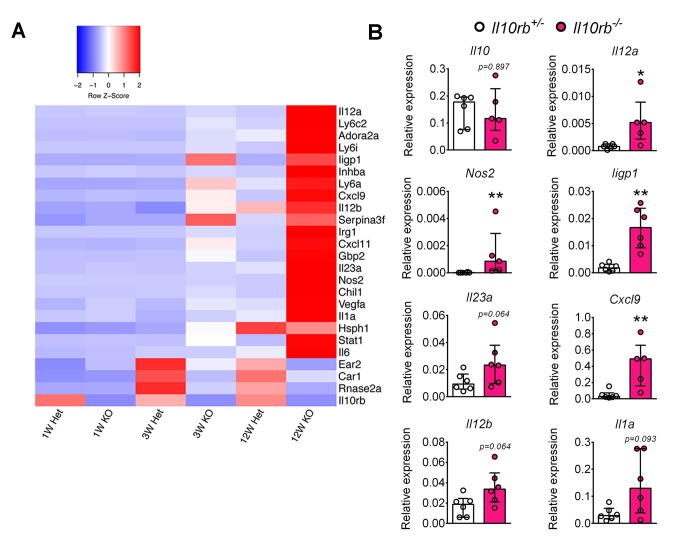
Lamina propria macrophages of infant Il10rb-/- mice exhibit proinflammatory transcriptional profile.Colonic LP MΦs (P3/P4; gated on CD45+CD11b+CD11cint CD103-CD64+Ly6C-MHCII+ cells) were sorted (minimum 10,000 cells), RNA was prepared, and RNA-seq was performed. (A) Heatmap showing relative expression intensity of >3 fold differentially expressed genes in the LP MΦs between Il10rb-/- (KO) and Il10rb+/- (Het) mice. Genes were identified based on the differential expression in LP MΦs between 3 week old Il10rb-/- and control mice. Each sorting time-point represents one mouse at 3 and 12 weeks, whereas pooled colons from 4 to 5 mice for 1 week data points were used. (B) Validation of RNA-seq data by qRT-PCR for selected genes and Il10 from LP P3/P4 MΦs sorted from Il10rb-/- and littermate Il10rb+/- mice at 3–4 weeks of age. *p<0.05, **p<0.01, n = 6 mice in each group. Median with IQR is shown. Additional data files showing codes used for ‘R’ scripts (Figure 3—source data 1 and Figure 3—source data 2), and the normalized gene expression values for Figure 3A (Figure 3—source data 3) are provided.DOI:
http://dx.doi.org/10.7554/eLife.27652.00810.7554/eLife.27652.009Figure 3—source data 1.R-script used to generate differential gene expression data shown in Figure 3A.DOI:
http://dx.doi.org/10.7554/eLife.27652.00910.7554/eLife.27652.010Figure 3—source data 2.R-script used to generate heat map shown in Figure 3A.DOI:
http://dx.doi.org/10.7554/eLife.27652.01010.7554/eLife.27652.011Figure 3—source data 3.Normalized gene expression values used to construct heat map shown in Figure 3A.